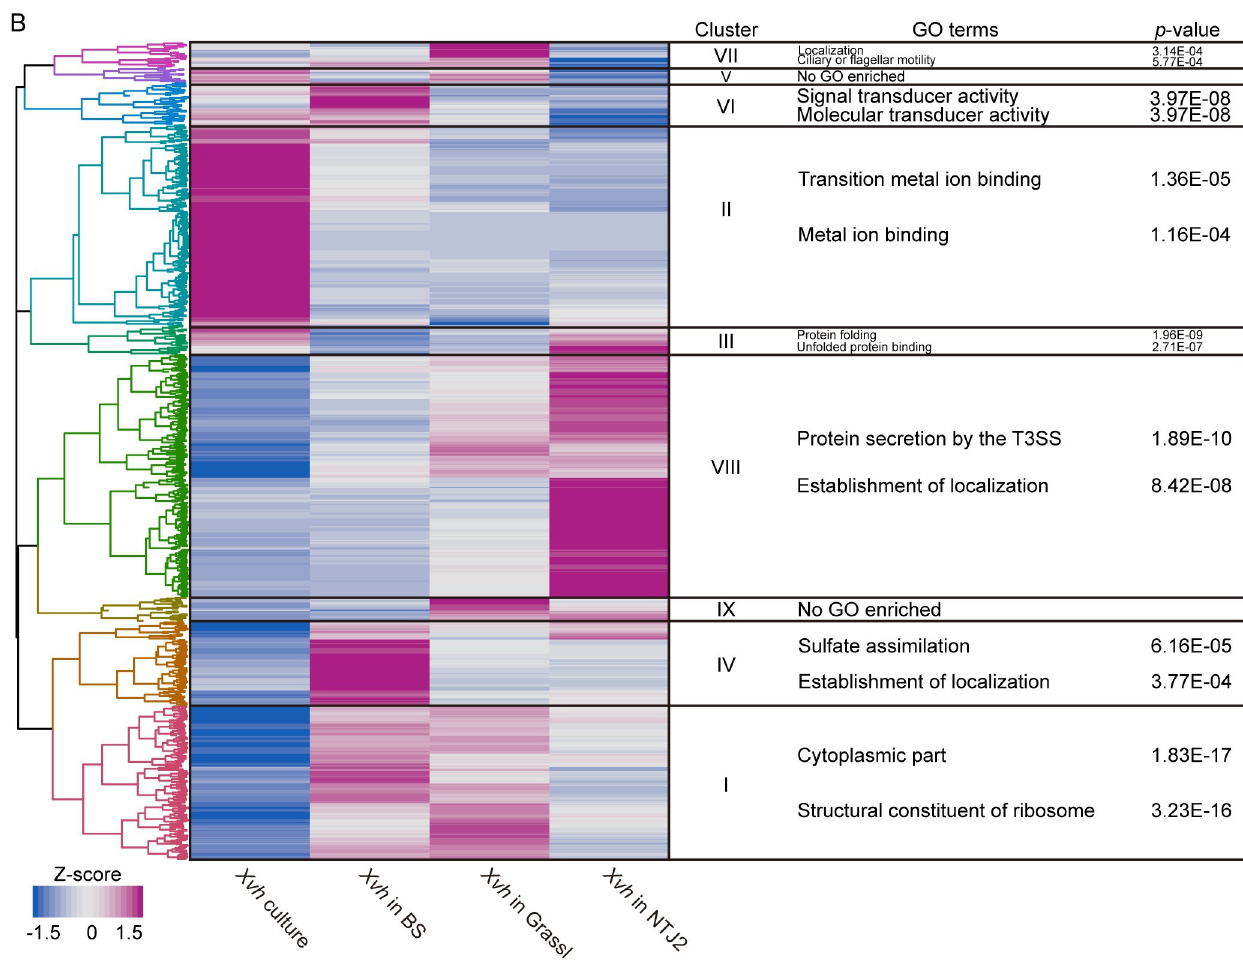
Fig 8. Hierarchical clustering analysis of differentially expressed genes in Xvh . Analysis based on gene expression from Xvh culture and in planta samples. Xvh genes identified as differentially expressed in at least one of the pairwise comparisons between Xvh culture and Xvh in planta (FDR adjusted p value < 0.05, |log 2 fold change| > 2) were used for analysis. The transformed Z-score value was generated from FPKM (fragments per kilobase per million mapped sequence reads) values for each condition. The top 2 GO terms based on p value (adjusted by the Benjamini-Hochberg method) are listed in this figure. The complete lists of GO terms are provided in S12 Table. BS (water-soaked lesions), Grassl (red lesions), and NTJ2 (resistance).